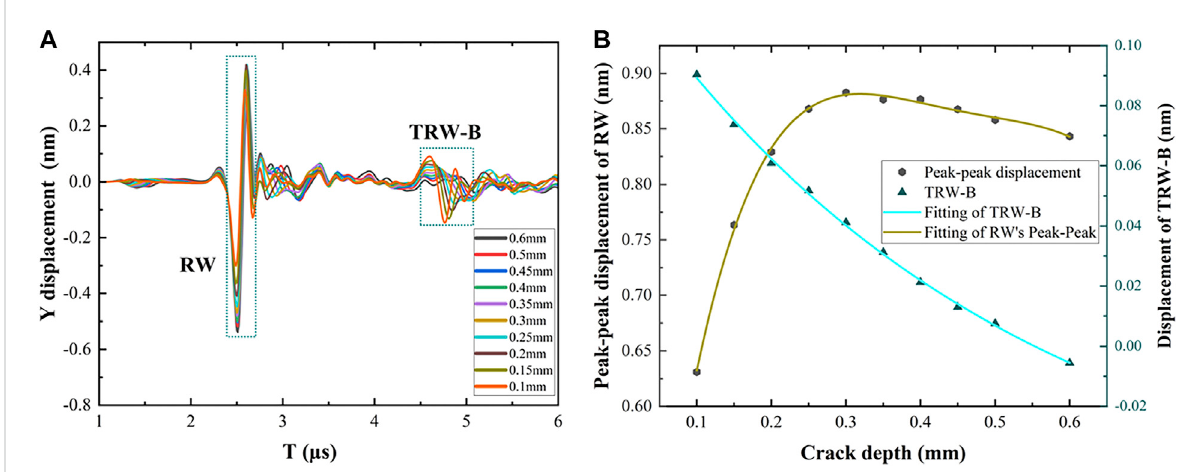
FIGURE 9 Y displacement and Fitting curves : (A) Y displacement of different depths on the same side; (B) Fitting curves of TRW-B (bule) and RW ’ s Peak- peak (brown).